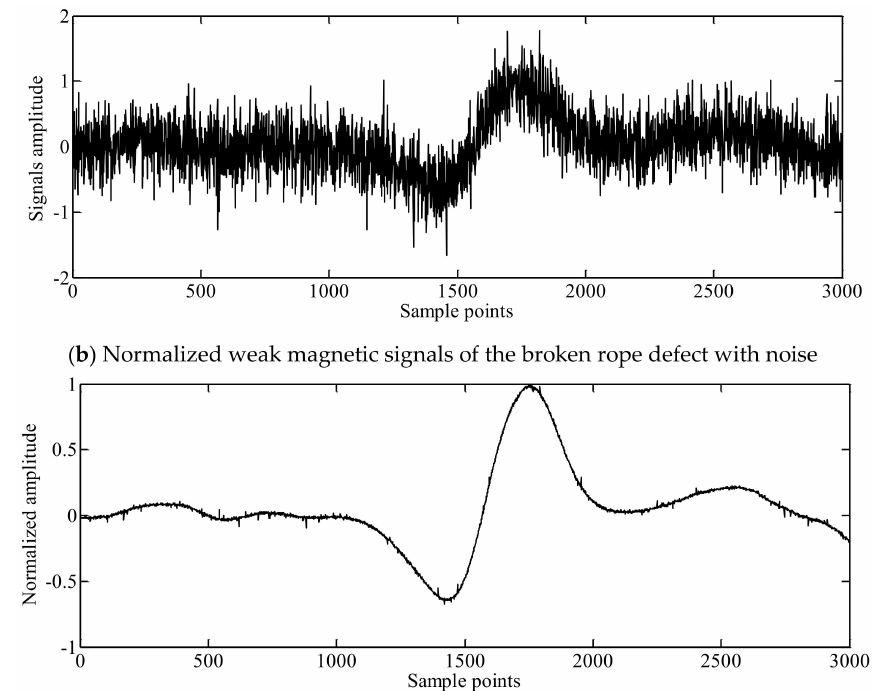
Figure 12. Normalized weak magnetic signals of the broken rope defect before and after noise reduction.